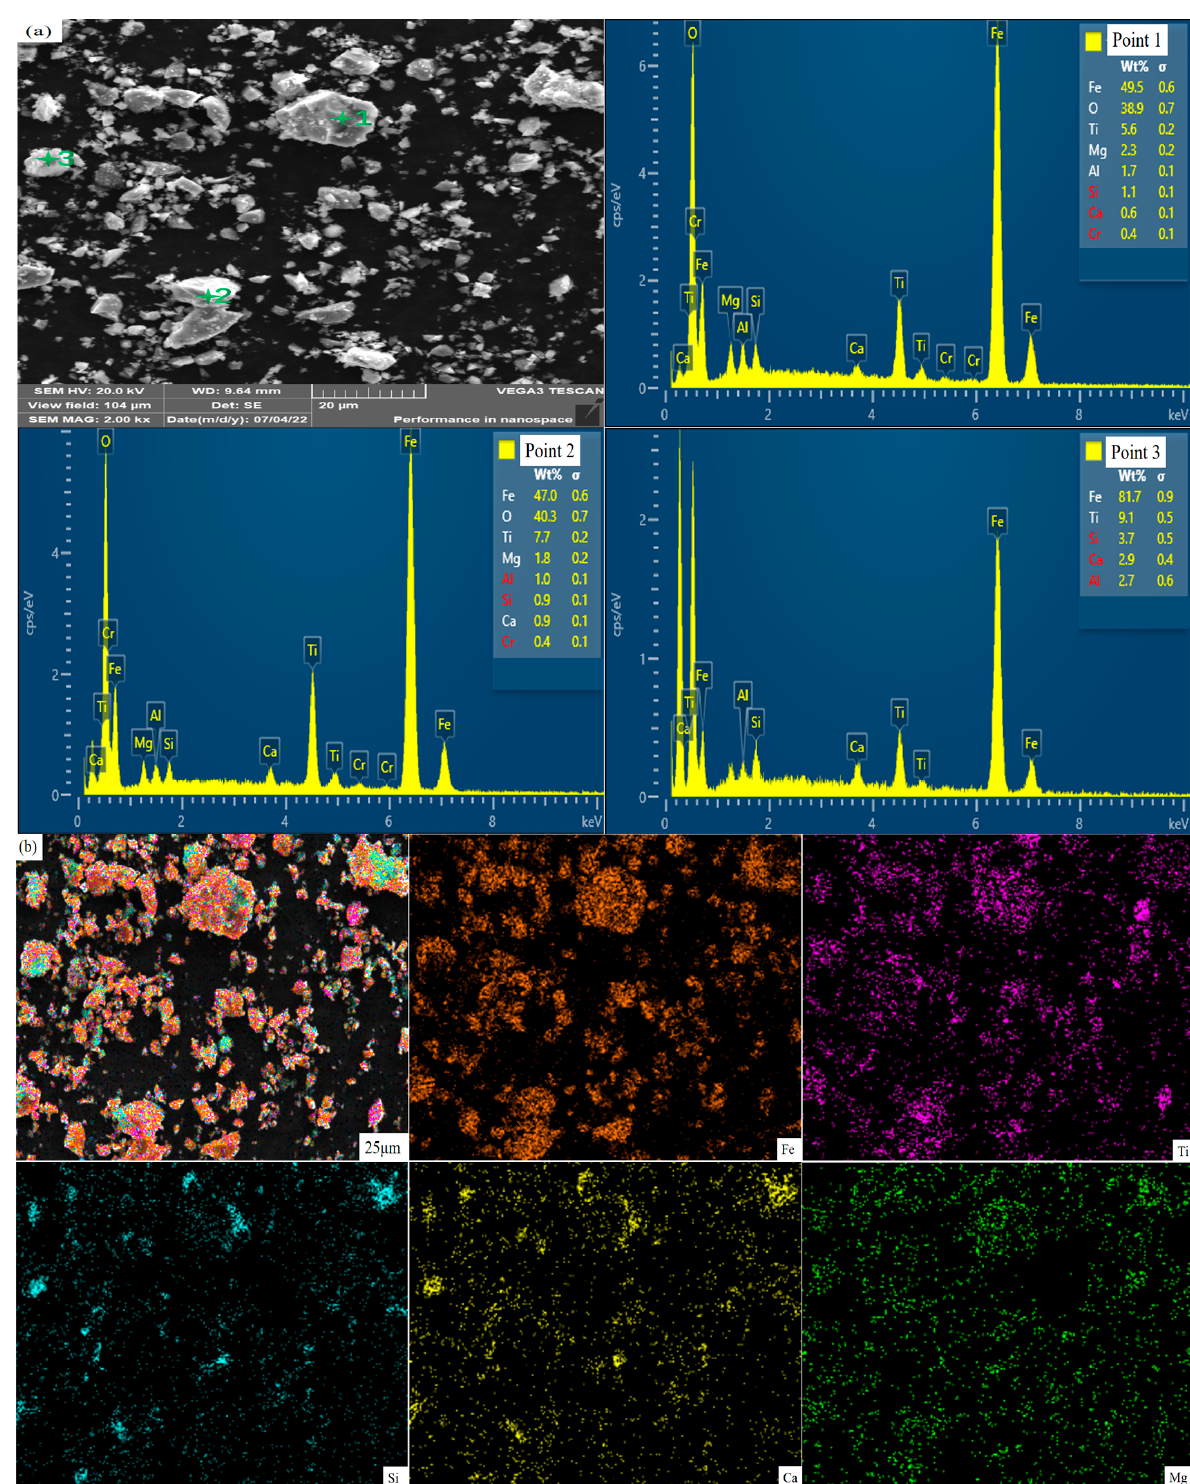
Figure 7. SEM ( a ) Spot scan, ( b ) Face scan images of pellets before leaching.